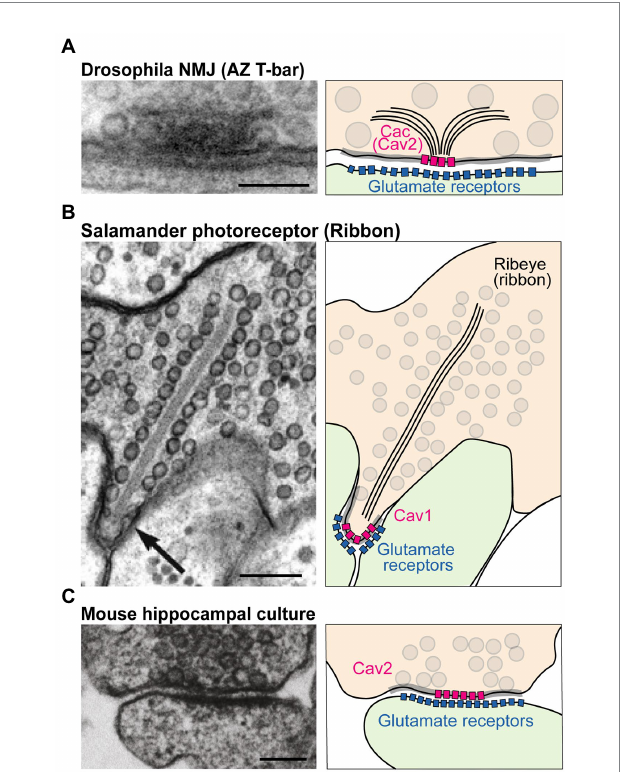
FIGURE 1 Structure and molecular composition of AZs. (A) Left: EM of an AZ at the Drosophila NMJ (modified from Fouquet et al., 2009; scale bar: 100 nm). Right: molecular depiction of the AZ. The presynaptic terminal is colored in orange, and the postsynaptic cell green. Gray circles represent SVs. The gray highlighted zone along the presynaptic membrane marks the AZ area. Bruchpilot (BRP; black lines) forms the “T-bar” structure together with other scaffolds (not shown). The presynaptic Ca v 2 channel Cacophony (Cac) clusters at the base of the T-bar, while Glutamate Receptors cluster postsynaptically. (B) EM (modified from Thoreson et al., 2004; scale bar: 200 nm) and depiction of a salamander photoreceptor ribbon synapse. The ribbon is an electron dense projection (formed by the protein Ribeye) and is lined with SVs. Ca v 1 family channels mediate fusion at this synapse. (C) EM (modified from Kaeser et al., 2011; scale bar: 100 nm) and model of a mouse hippocampal cultured synapse. SV fusion at mammalian CNS neurons is primarily supported by Ca v 2.1 and Ca v 2.2 channels